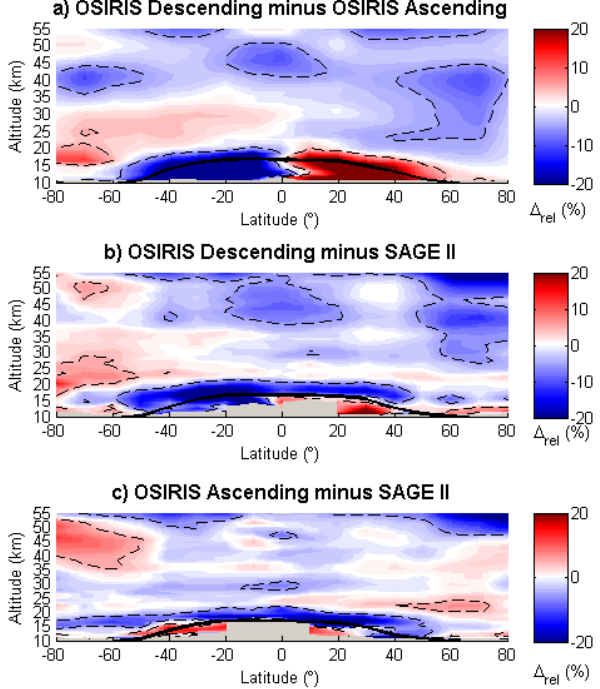
Fig. 10. As for Fig. 6a for (a) OSIRIS descending node mi- nus OSIRIS ascending node measurement pairs for 2001–2005, Figure 10: As for Fig. 6a for (a) OSIRIS descending node minus OSIRIS ascending node 2 (b) OSIRIS descending node minus SAGE II measurement pairs, and (c) OSIRIS ascending node minus SAGE II measurement pairs. measurement pairs for 2001-2005, (b) OSIRIS descending node minus SAGE II measurement 3 OSIRIS ascending and descending node measurement pairs and pairs, and (c) OSIRIS ascending node minus SAGE II measurement pairs. OSIRIS ascending 4 OSIRIS and SAGE II measurement pairs were all selected with and descending node measurement pairs and OSIRIS and SAGE II measurement pairs were 5 broad coincidence criteria (see Table all selected with broad coincidence criteria (see Table 1). 6